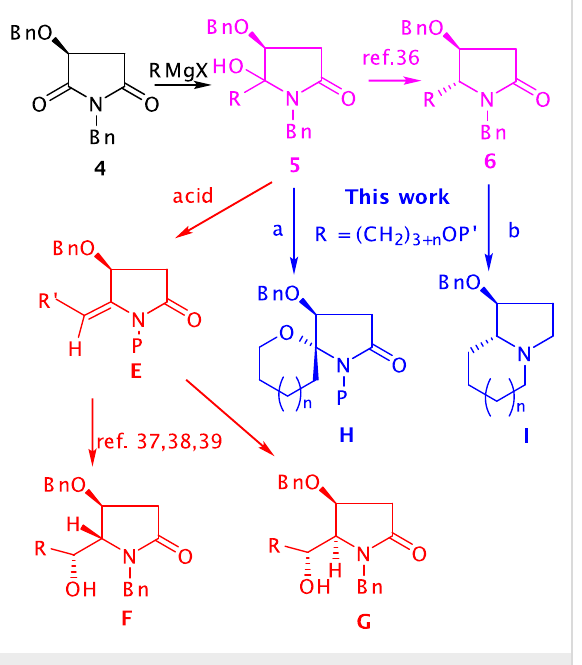
tions [TsOH (cat.)/CH 2 Cl 2 , r.t.] for 0.5 h resulted in the forma- tion of the desired functionalized aza-spiropyran derivative 7 as